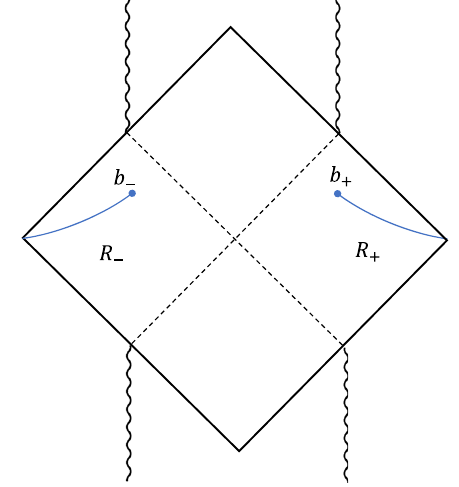
Fig. 2 Penrose diagram of an eternal Reissner–Nordström black hole [12] in the absence of island surface